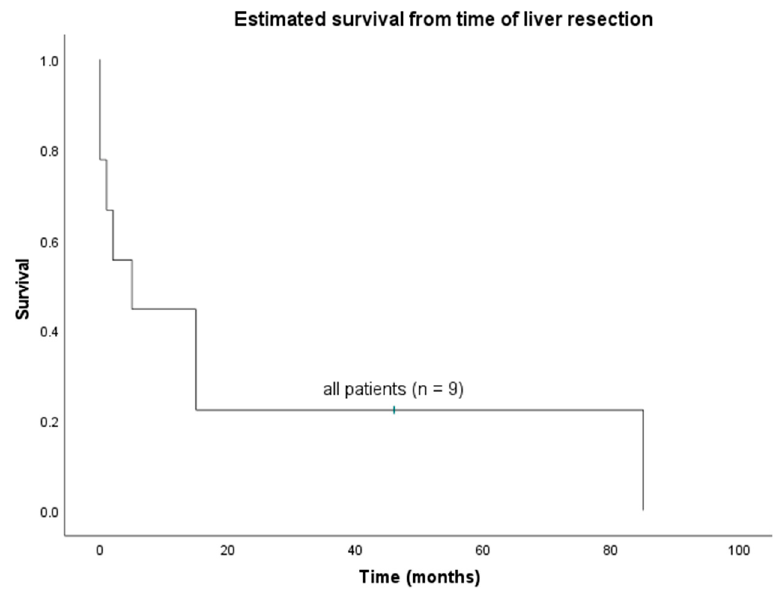
Figure 1. Overall survival of all patients undergoing hepatectomy for PHA ( n = 9). In univariate analysis, R1 status (R0 vs. R1, p = 0.04, Figure 2) and tumor rupture (rupture vs. no rupture, p = 0.005, Figure 3) were significantly associated with worse OS. In multivariate analysis, none of the analyzed factors showed a significant impact on OS (Table 2).